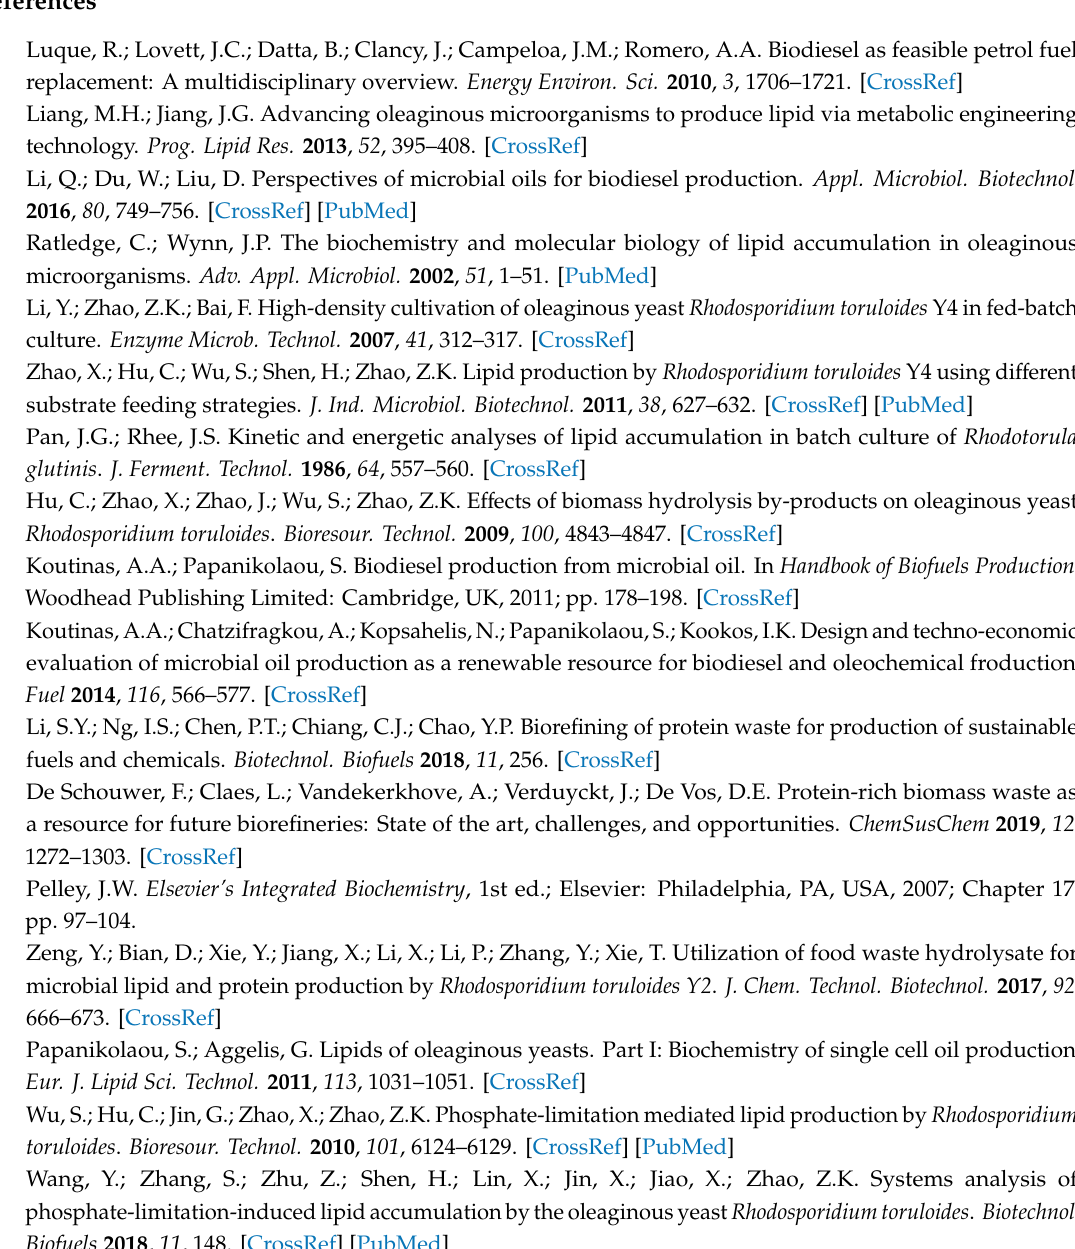
Table S1: Gradient condition for analyzing all 20 proteinogenic amino acids with IC. Table S2: Analysis of variances for cell mass in Figure 1 (all AAs). Table S3: Analysis of variances for cell mass in Figure 1 (Gly and Tyr). Table S4: Analysis of variances for cell mass in Figure 1 (Met, His, Arg, Thr, Trp, Tyr, Lys, and Leu). Table S5: Analysis of variances in Figure 2. Figure S1: Chromatogram of standard mixture of all 20 proteinogenic amino